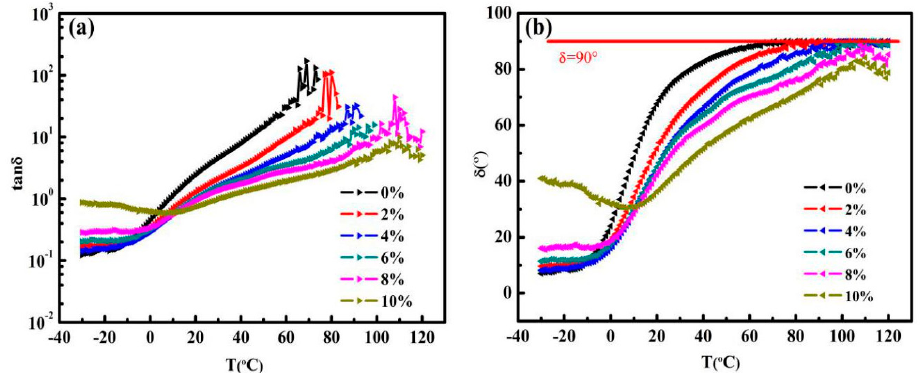
Figure 10. ( a ) Damping factor versus temperature from − 30 to 120 °C. ( b ) Phase angle versus temperature from − 30 to 120 °C.